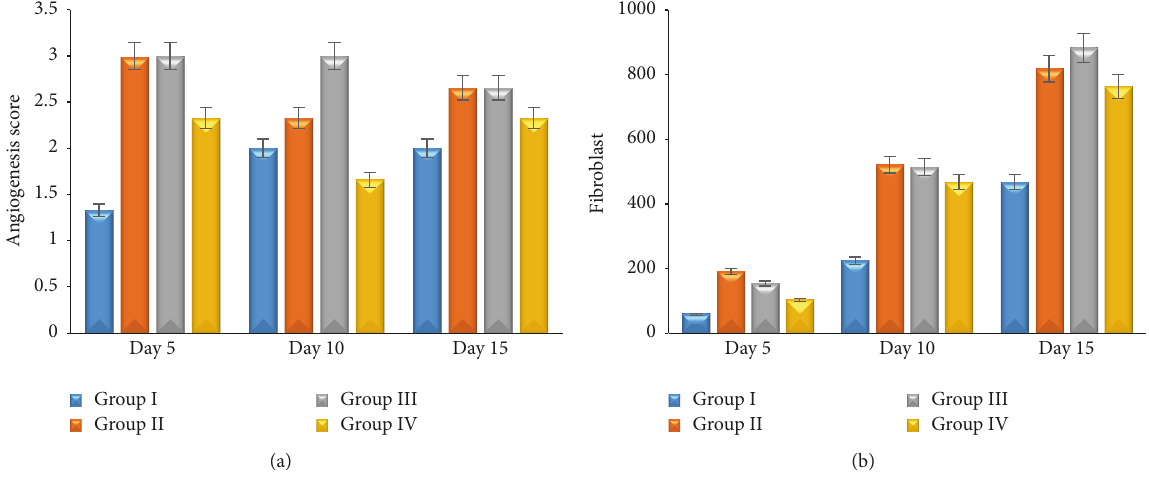
Figure 3: The average score of angiogenesis (a); the average number of fibroblast (b) on skin wound.